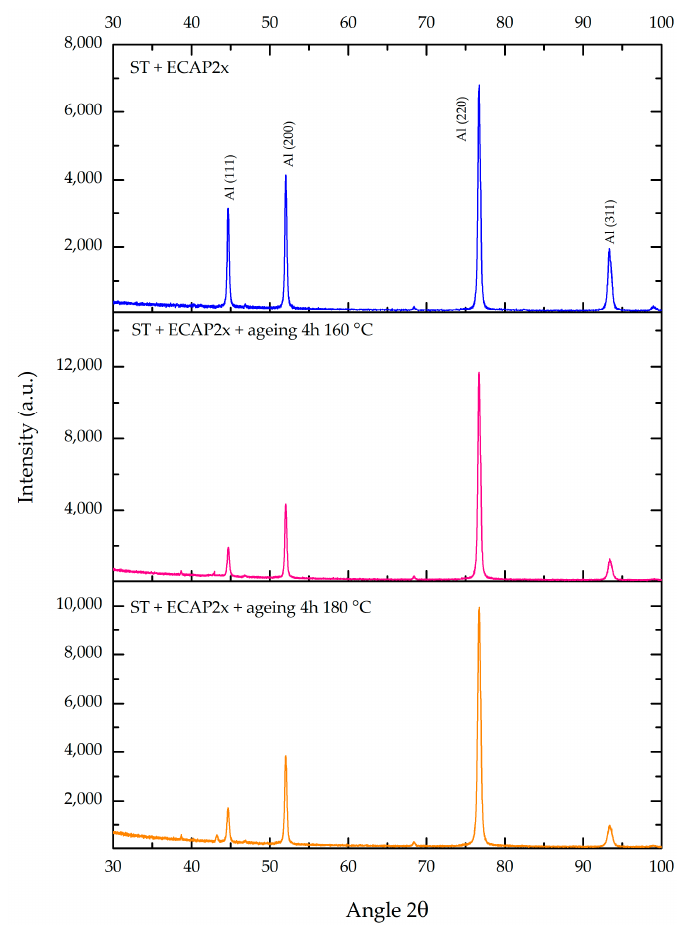
Figure 8. X-ray diffraction pattern of the AlMg5 specimens.